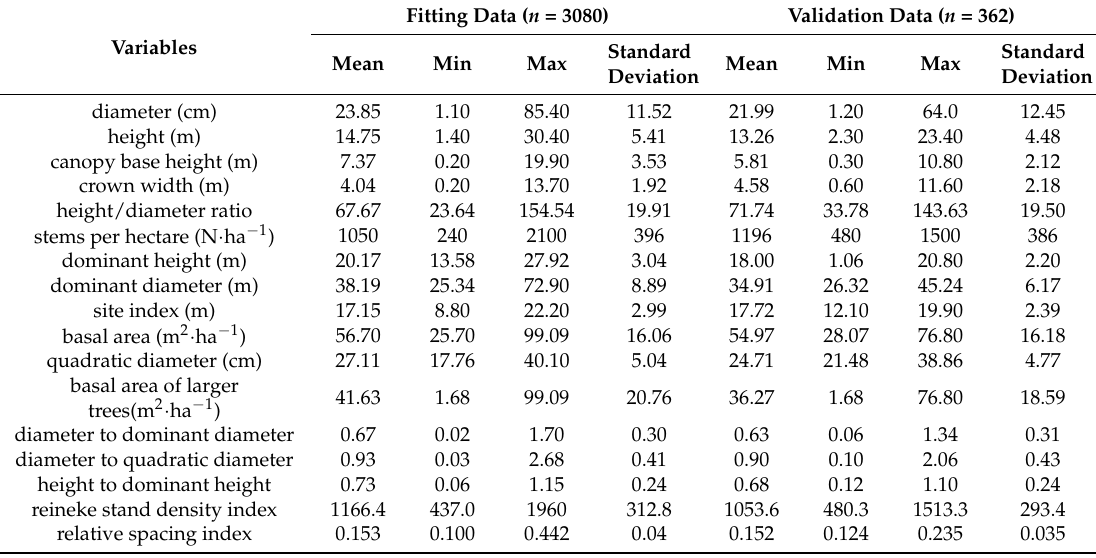
Table 1. Descriptive statistics of the total